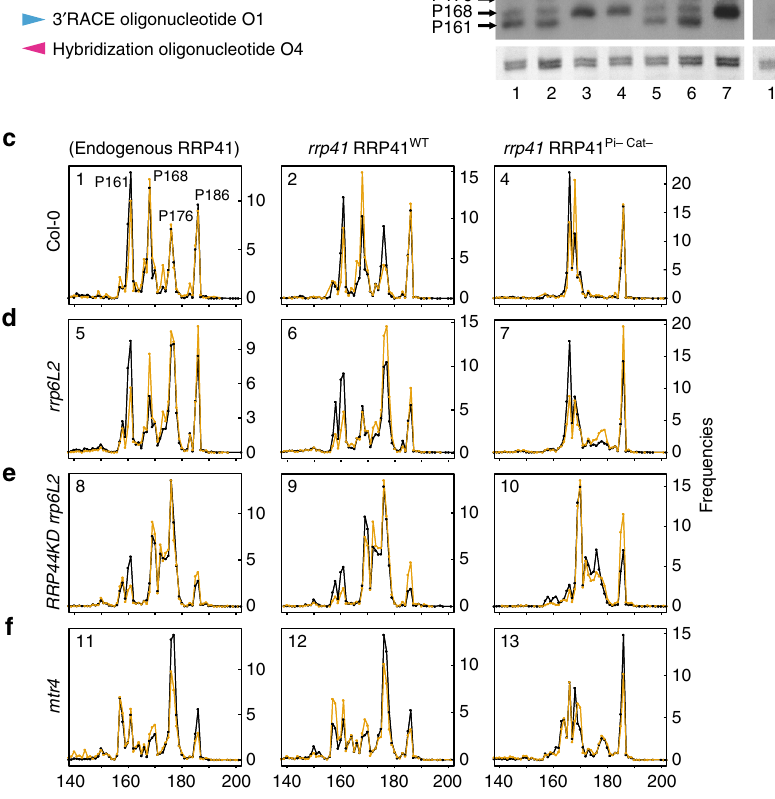
Fig. 3 Exo9 activity participates in the elimination of rRNA maturation by-products. a Diagram of the 5 ′ ETS and its degradation intermediates. A portion of the 35S rRNA precursor comprising the 5 ′ ETS is drawn at the top. Numbers refer to the transcription start site. Vertical arrows above the diagram indicate processing sites. Key steps leading to the elimination of the 5 ′ ETS are sketched below. The location of the hybridization oligonucleotide O4 used for Northern analysis is shown by a magenta arrow. The location of the oligonucleotide O1 used for 3 ’ RACE-seq is shown by a blue arrow. b Northern blot analysis of Exo9 ’ s speci fi c in vivo substrates during the elimination of the 5 ′ ETS. The main 5 ′ ETS degradation intermediates are noted as P-P ’ and P-P1 on the right. Two exposures of the lower part of the blot are shown. A portion of the Ethidium bromide (Etbr)-stained gel is used as control for loading. Lane numbers at the bottom refer to the panels shown in c – f . c – f High density mapping of 3 ′ extremities of P-P1 degradation intermediates by 3 ´ RACE-Seq. Density pro fi les are shown for positions +140 to +200, +1 corresponding to the fi rst nucleotide of the P-P ’ fragment. Two biological replicates are shown in black and orange, respectively. The presence of endogenous RRP41 or the complementation of the rrp41 mutations by RRP41 WT or RRP41 Pi-Cat- , respectively, is indicated at the top of the panels. The Col-0, rrp6L2 , RRP44KD rrp6L2 or mtr4 genetic backgrounds are indicated on the left in c , d , e , and f , respectively. Numbering of each panel refers to the lane numbers of the northern blot shown in